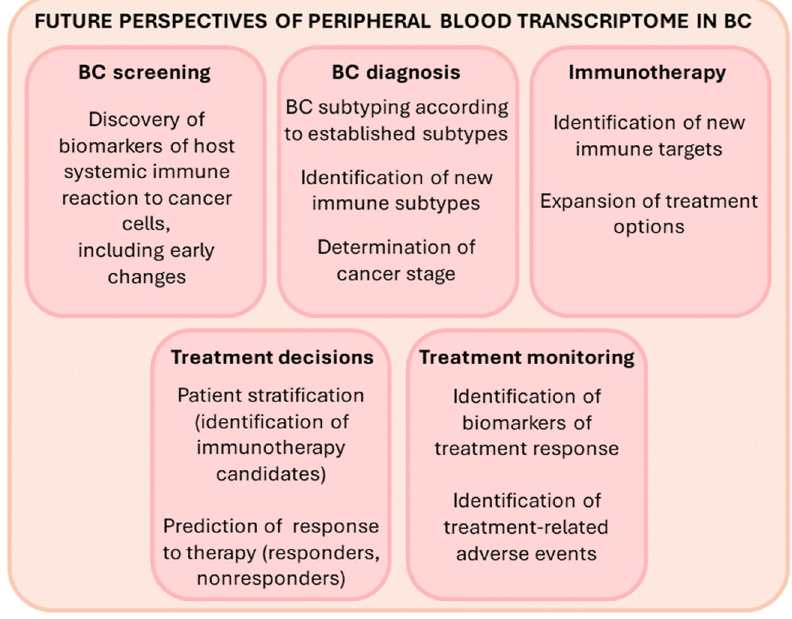
Figure 4. The potential uses of PBC transcriptome analyses for precision medicine in the future.